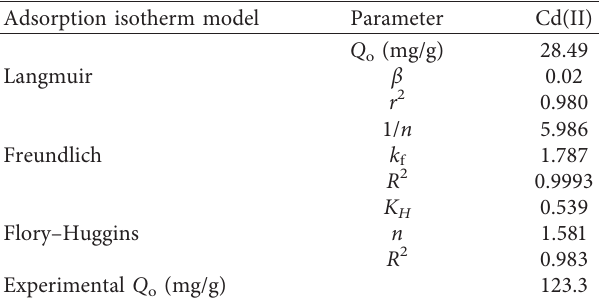
Table 3: Adsorption isotherm model parameters for Cd(II). Adsorption isotherm model